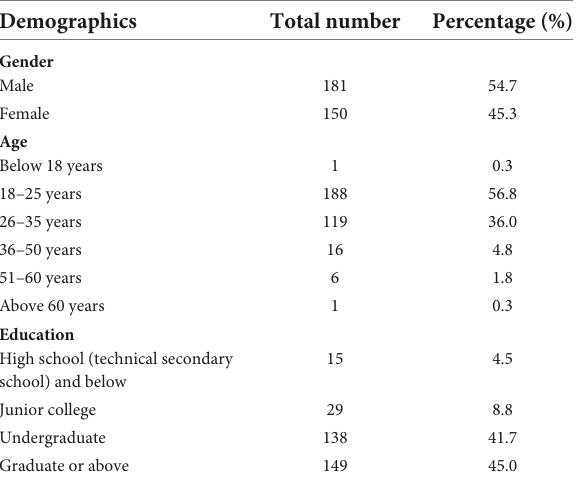
TABLE 1 Descriptive statistics of demographic characteristics.